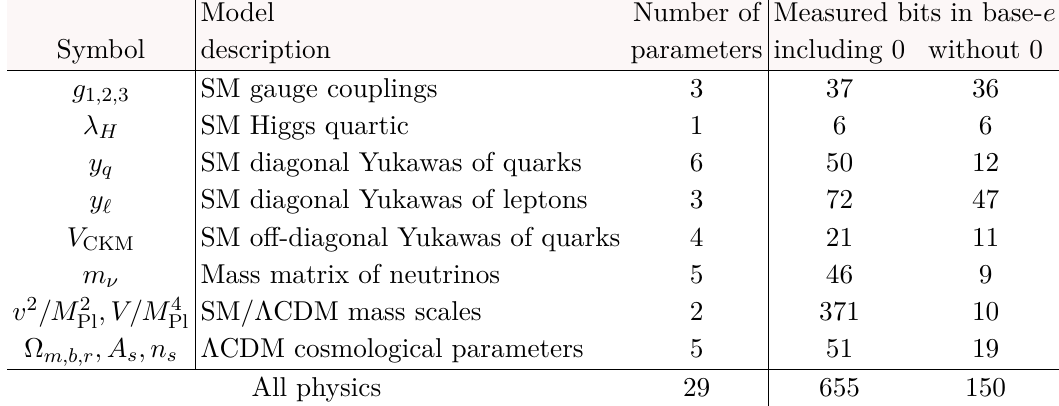
Table 2 . The free fundamental parameters of the Standard Model of particle physics and of cosmology, that act as ‘coordinates’ in the landscape, and the number of digits to which they have been measured so far. Some digits get lost, due to QCD uncertainties, when renormalized to higher √ energy. For a parameter measured as µ ± σ , the column ‘digits including 0’ gives − ln 2 πeσ , as √ in eq. (A.8). The column ‘digits without 0’ gives − ln 2 πeσ/µ , as in eq. (A.9). One or the other can be relevant, depending on how small numbers arise in the landscape. We have not included the bound on θ , as the possible existence on axion would allow to relax QCD